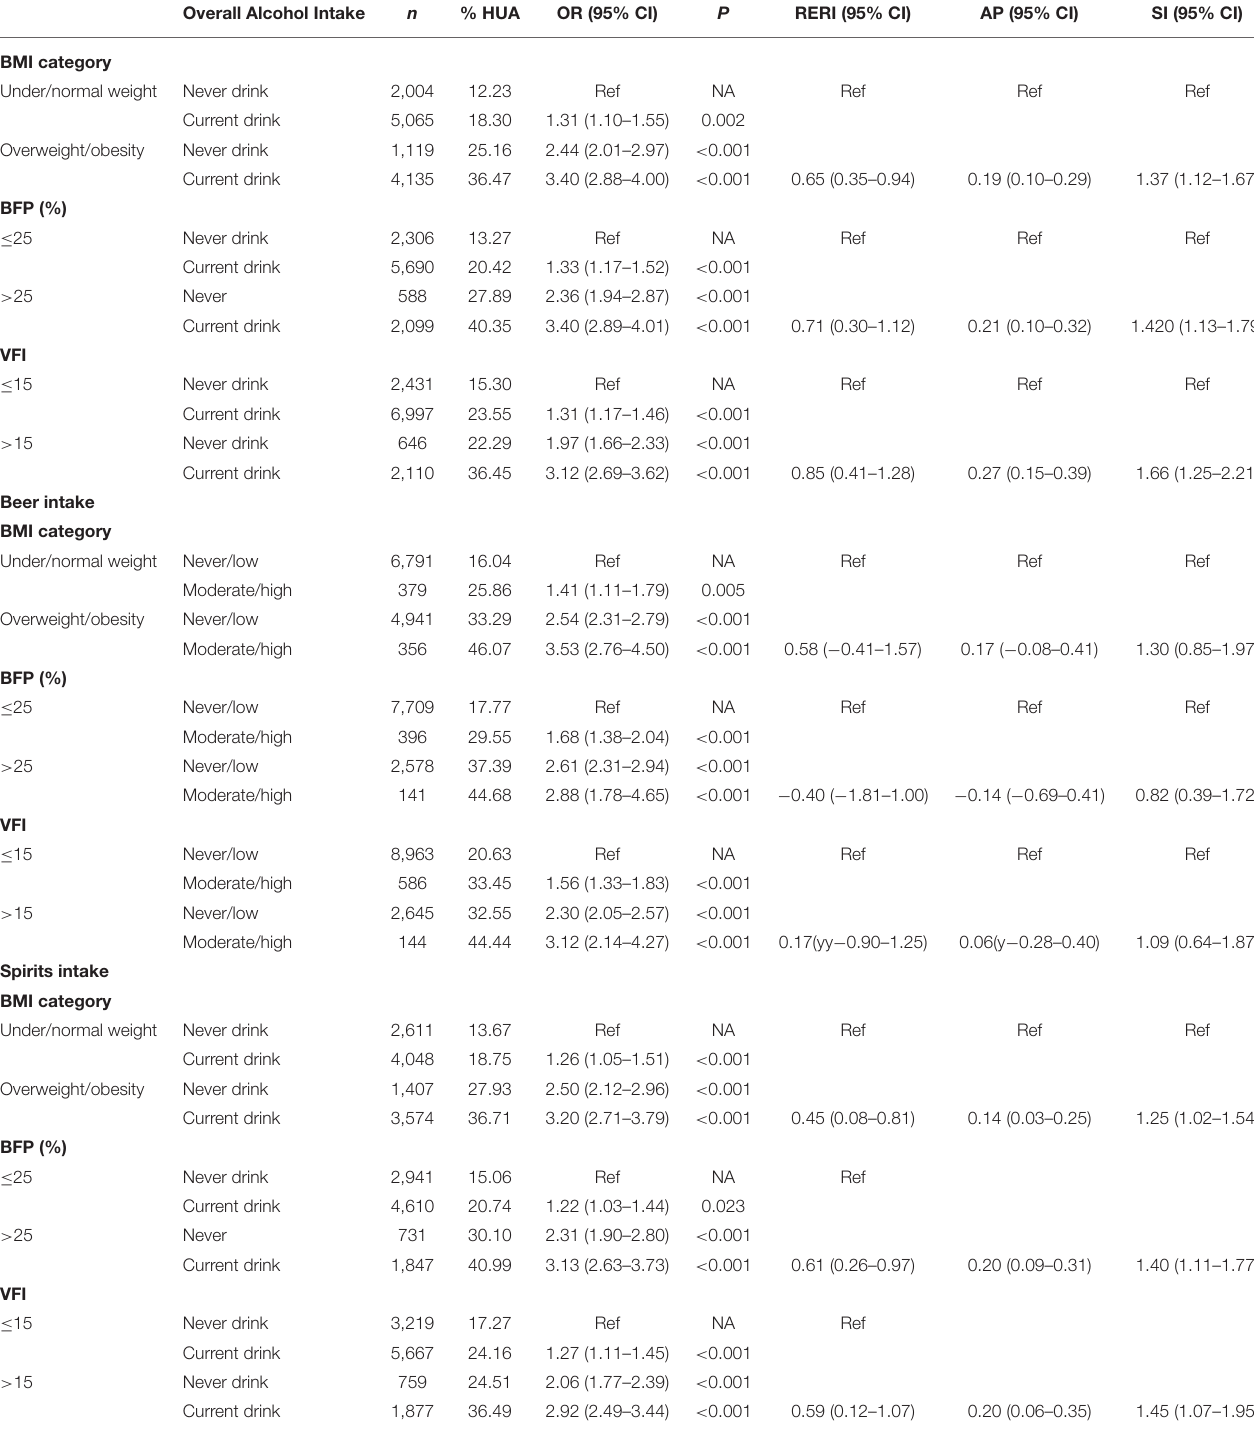
TABLE 4 | The effect of excess adiposity and alcohol intake and their additive interaction on HUA among men aged 20–80 in mainland China. Overall Alcohol